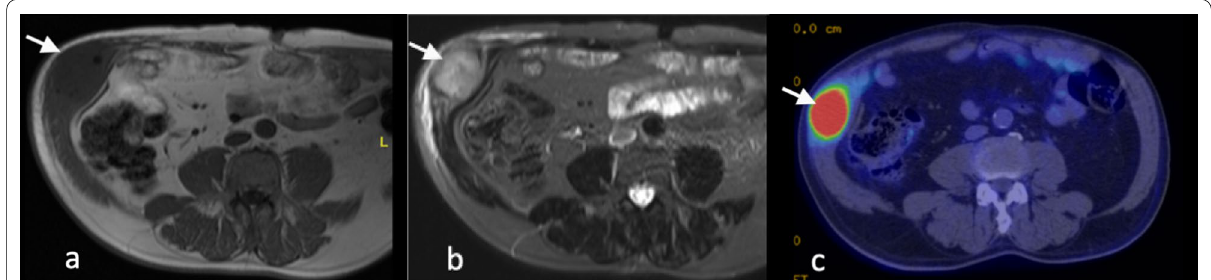
Fig. 16 a T1-weighted and ( b ) T2-weighted fat suppressed MR and ( c ) PET-CT images of TCC recurrence within the right anterolateral abdominal wall scar (white